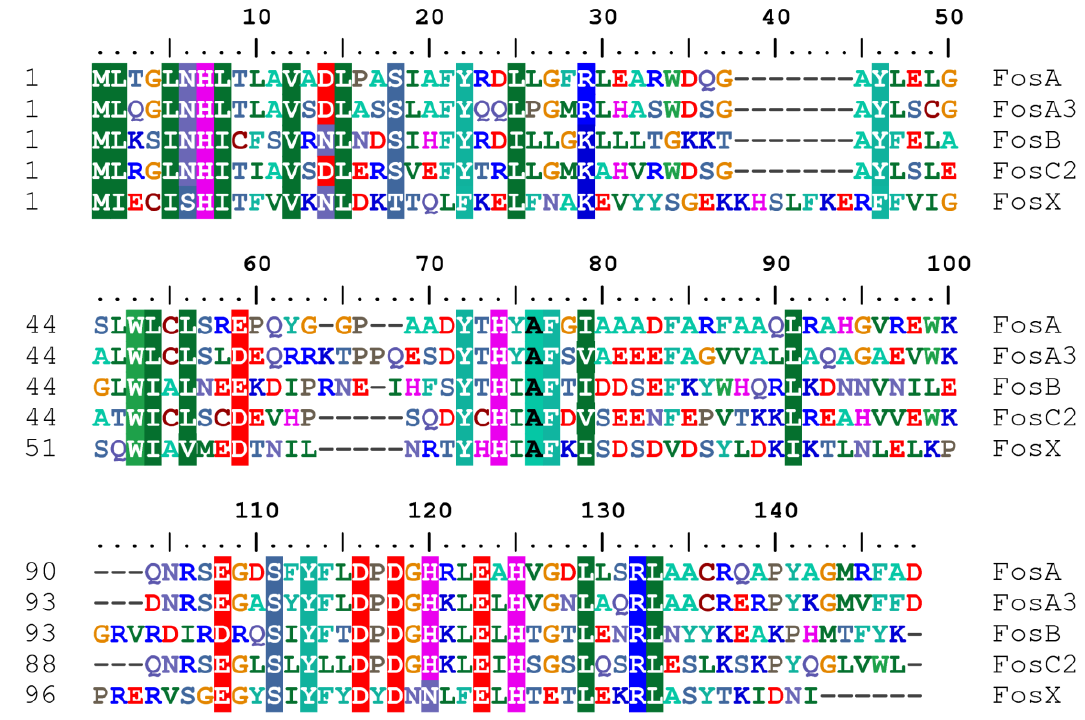
Figure 4. Amino acid sequence alignment generated by ClustalX (under Bioedict) of three representative sequences of fosfomycin resistance proteins (Fos) present in different bacterial species. Represented sequences are FosA [ P. aeruginosa 18A], FosA3 [ E. coli ], FosB [ S. aureus subsp . aureus USA300_TCH1516 ], FosC2 [ E. coli ] and FosX [ Clostridium botulinum Ba4 str. 657]. Fos enzymes belong to the same divalent metal-ion dependent metalloenzymes, the vicinal oxygen chelate superfamily (VOC), sharing a high number of core-conserved or identical residues in their